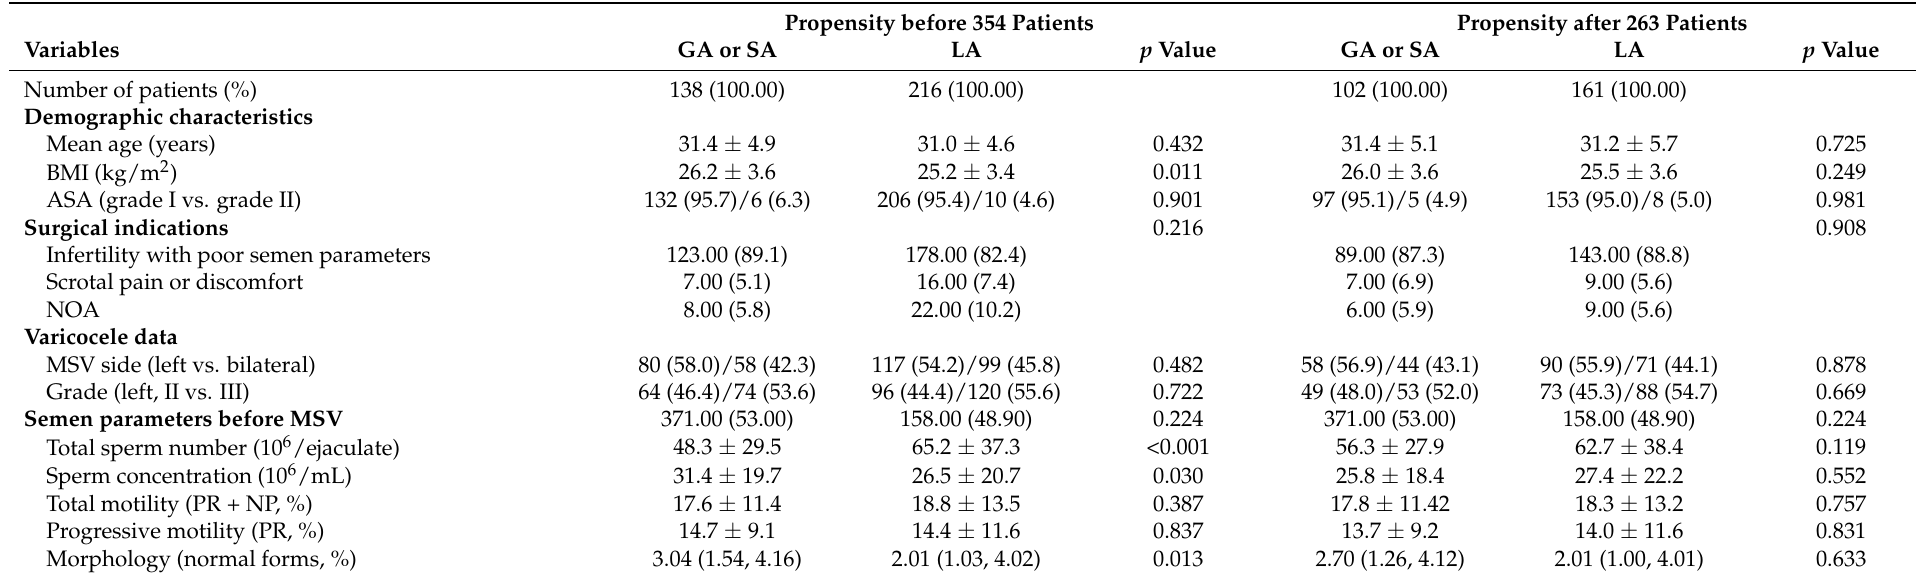
Table 1. Demographics and clinical data in this cohort according to the anesthesia type before and after